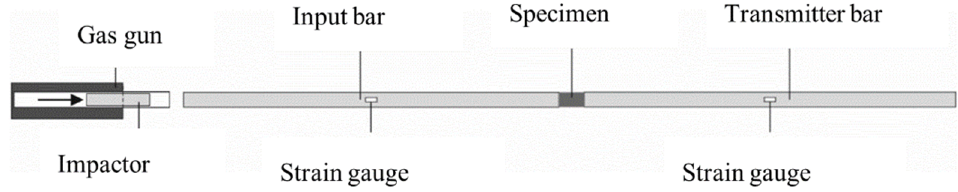
Figure 1. Schematic view of the split-Hopkinson pressure bar (SHPB) [22].